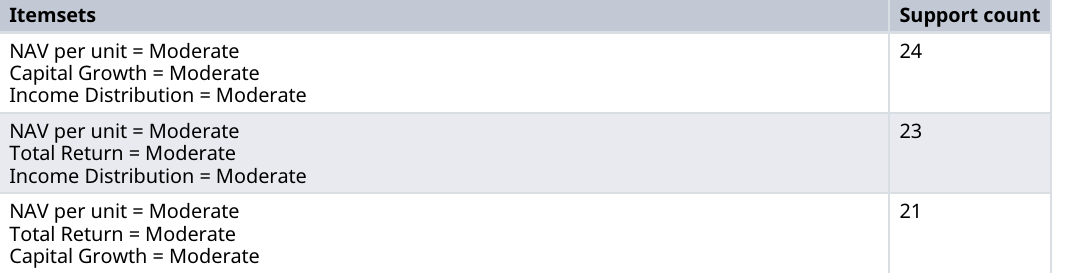
Table 4. Association rules mining applied to Cluster 4.